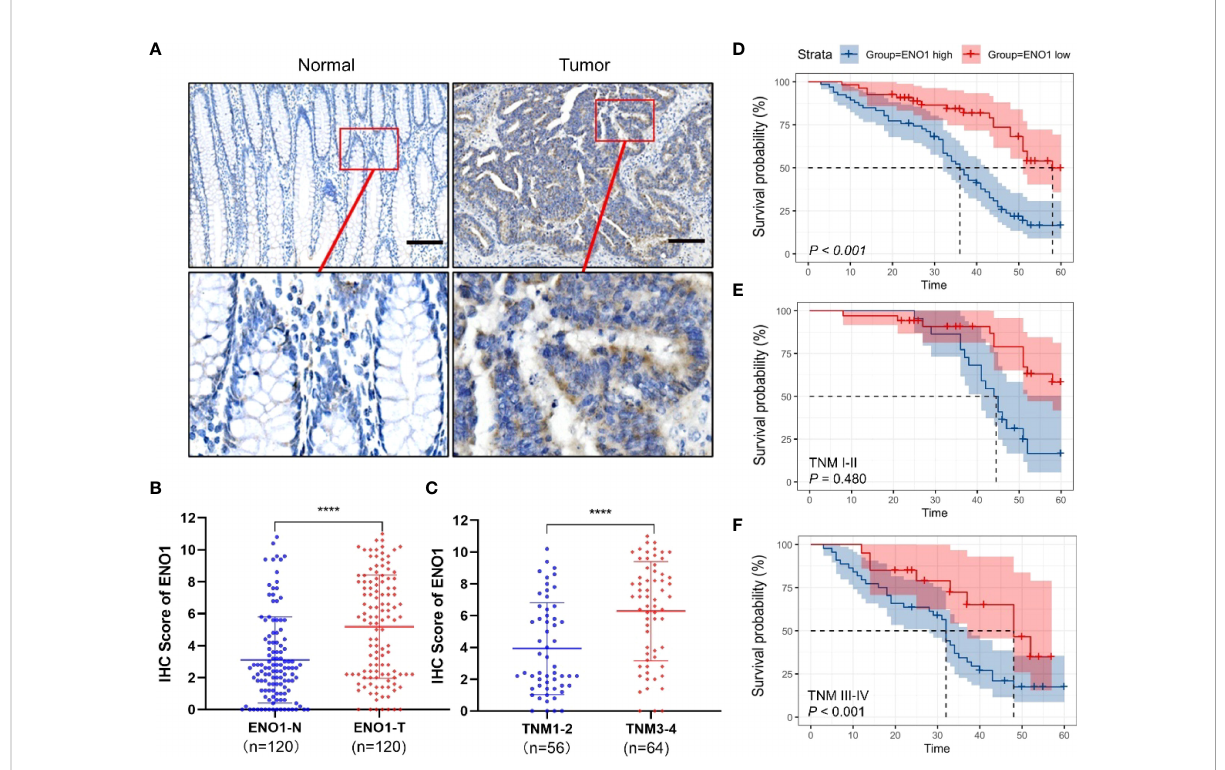
FIGURE 1 Expression of ENO1 in CRC tissues. (A) Representative immunohistochemical (IHC) images showing in situ ENO1 expression in colorectal cancer (CRC) and normal tissues (scale bar = 100 m m). (B) IHC scores of ENO1 in CRC vs normal tissues. (C) IHC scores of ENO1 in T I-II vs T III-IV tissues. (D – F) Overall survival of CRC patients with high and low expressions (D) of ENO1 with TNM staging I-II (E) and III-IV (F) . Statistical analyses were performed via two-tailed Student t test. ****, P ≤ 0.001.